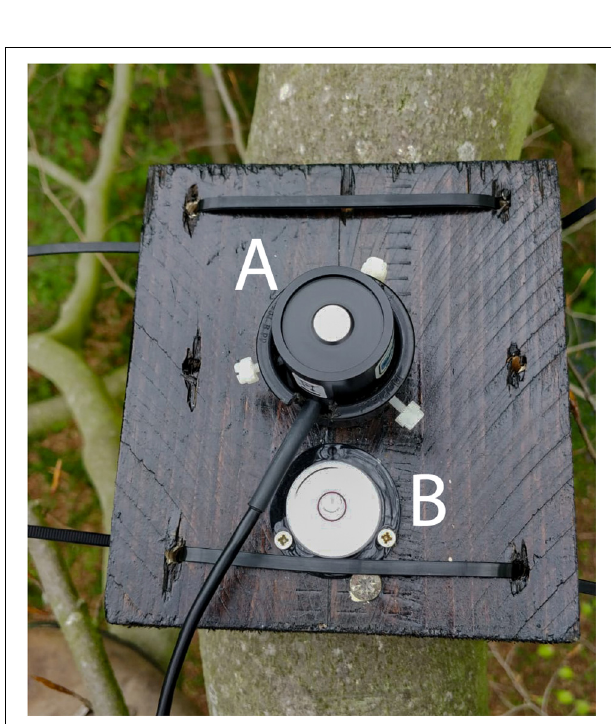
FIGURE 2 | Example of costume-build radiation sensor platform used, showing the pyranometer (A) and a spirit level (B)